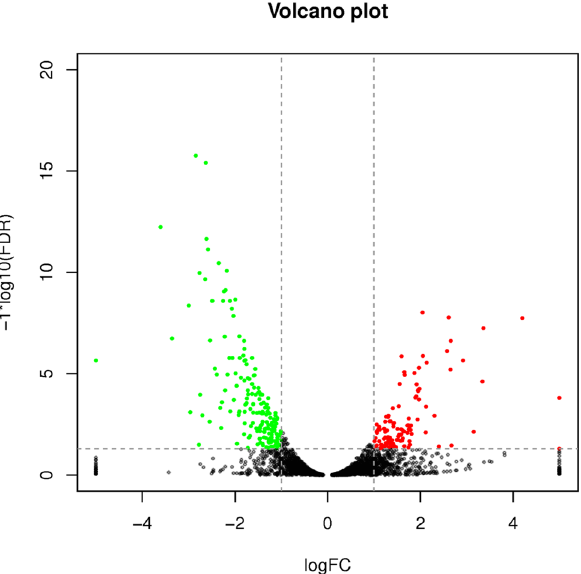
Figure 1. Volcanic plot of C versus E (The control group mark was C and the electromagnetic radiation exposure group mark was E. The abscissa indicates the logarithm value of the difference multiple between E and C. The ordinate indicates the negative Log10 value of the FDR of the difference between the two groups. The red (E relative to C, gene expression is upregulated) and green (E relative to C, gene expression is downregulated) dots indicate the difference in gene expression (the criterion is FDR < 0.05, and the difference multiple is more than twice), and the black points are not